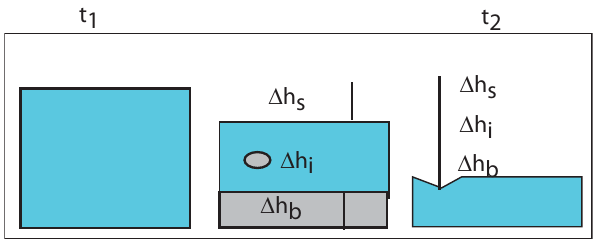
Fig. 15. The total thickness change of a glacier is caused by mass balance at the surface 1h s and internal and basal mass balance 1h i and 1h b if the effects propagate to the surface.